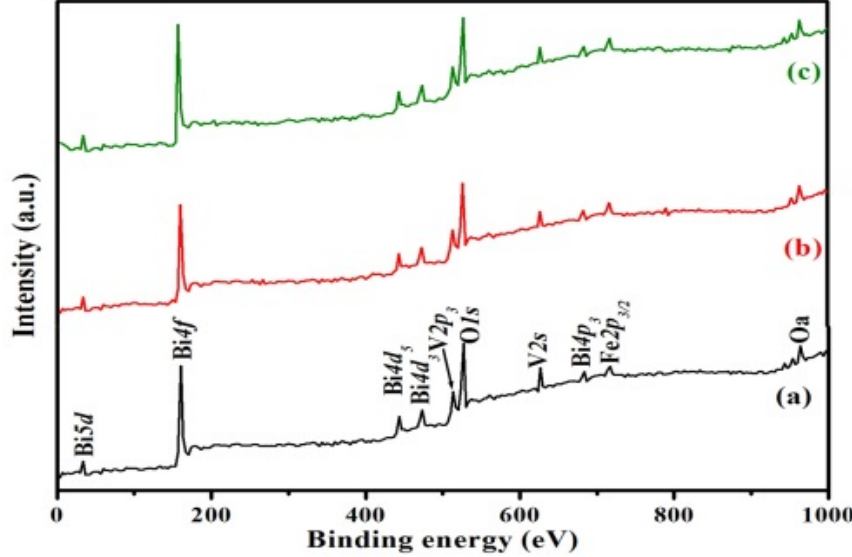
Figure 4. XPS profiles of BiFeVOx.y for ( a ) y = 0.03, ( b ) y = 0.07, and ( c ) y = 0.15.